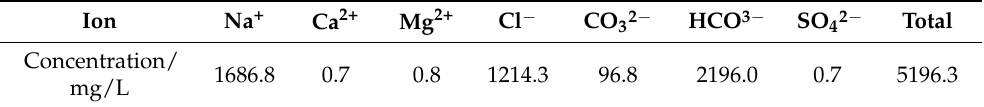
Table 1. Composition of simulated injection water.